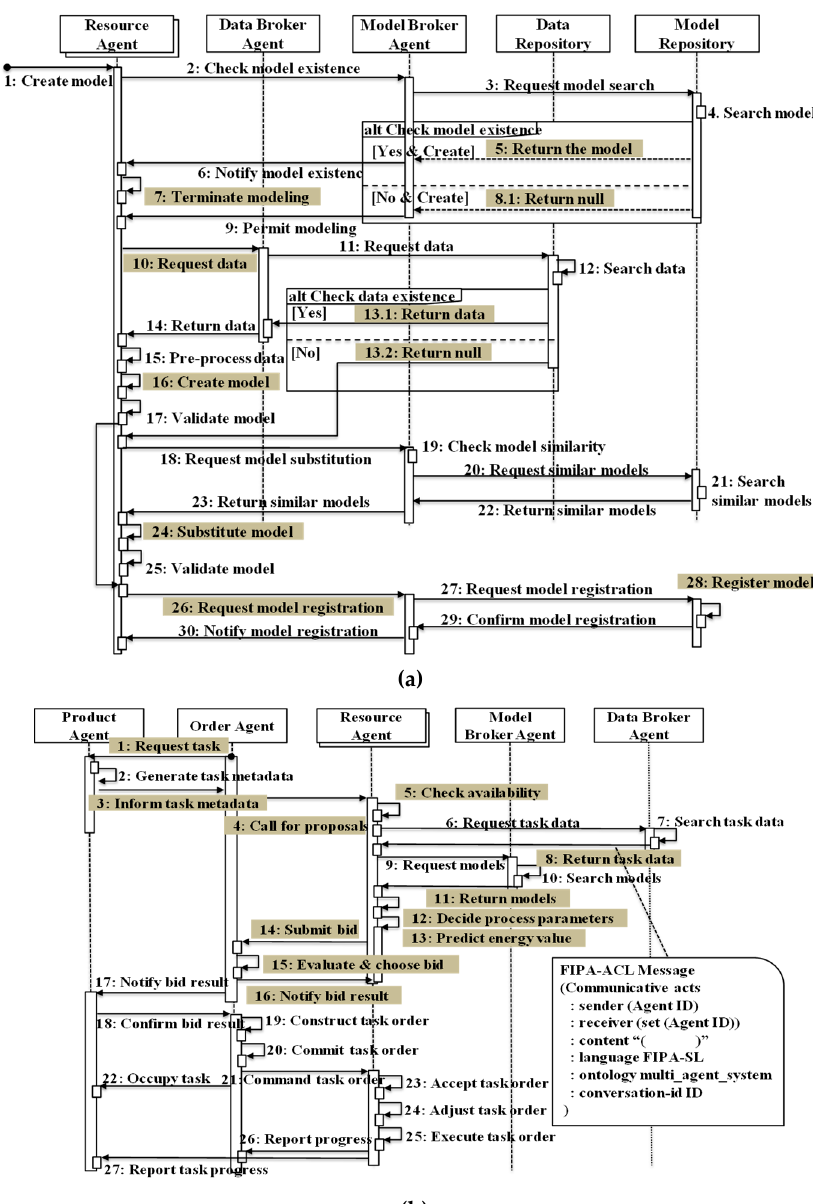
Figure 9. An operational procedure for a self-learning factory ( a ) Model creation, substitution, and registration; ( b ) Contract Net Protocol and model usage. FIPA-SL: Foundation for Intelligent Physical Agents – Semantic Language.